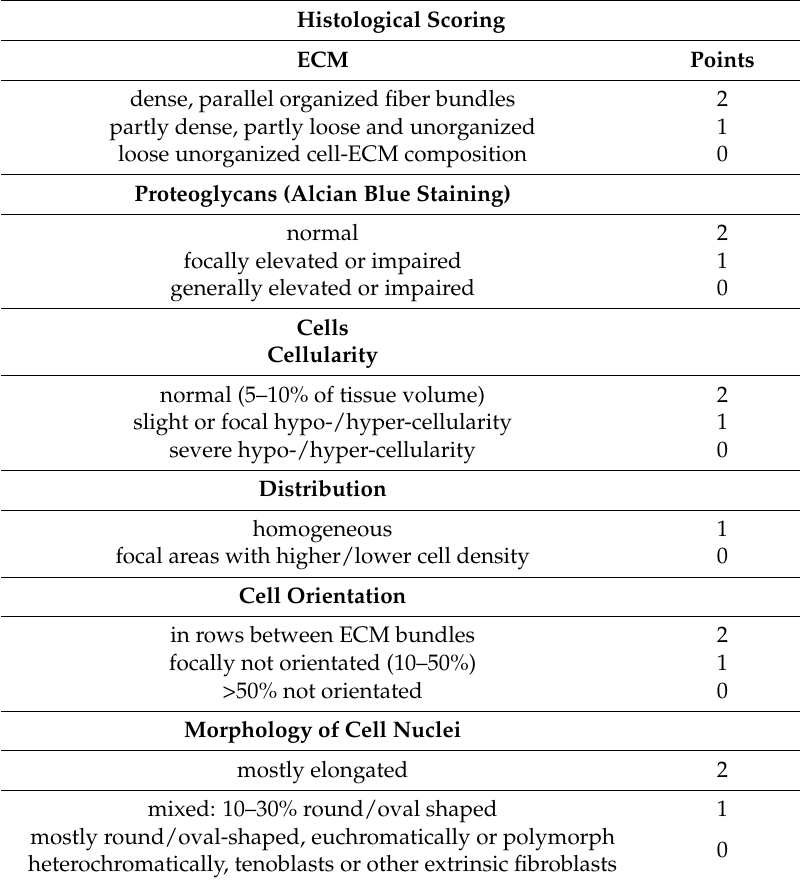
Table 2. Histological scoring (HE, AB) system for tendon explants. Histological Scoring